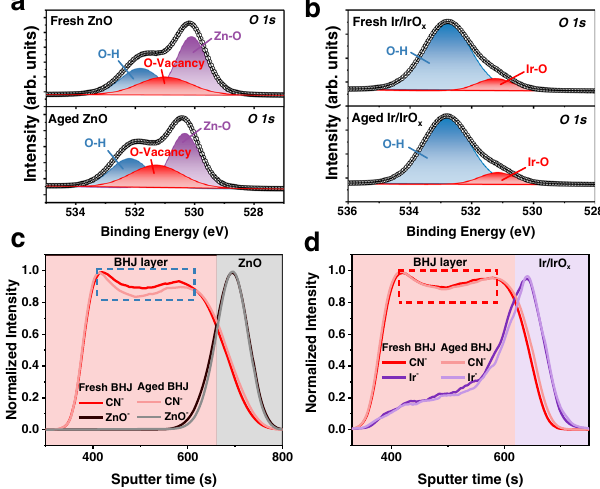
Fig. 5 | Molecular distribution. The XPS plots of core-level O 1s offresh and aged ZnO ( a ) and Ir/IrO x ( b ) fi lms. The time-of- fl ight secondary ion mass spectrometry (TOF-SIMS) plots of PM6:Y6 BHJ fi lms on ZnO ( c ) and Ir/IrO x ( d ) ETLs.